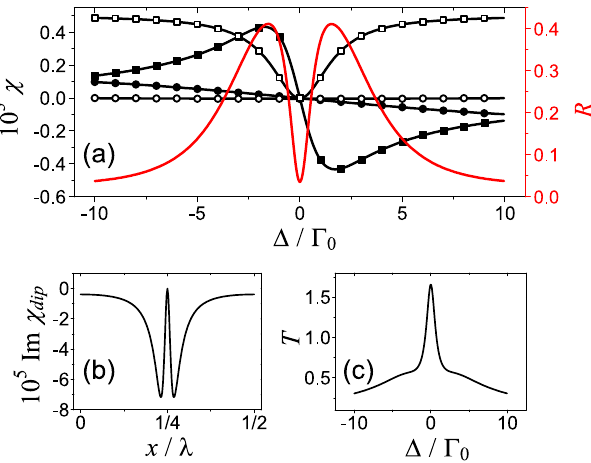
Figure 6. ( a ) The real (solid squares) and imaginary part (open squares) of χ at the nodes, together with real (solid circles) and imaginary part (open circles) of χ at the antinodes are plotted as the functions of probe detuning. The reflectivity (R) is presented in ( a ) as well using the red-color line. Here a m = 1.0 and R m = 0.7. The resultant imaginary part of susceptibility at the dip for different positions is present in ( b ), while the corresponding real part is zero. In ( c ) we provide the numerical result of spectral transmissivity. Other parameters are α =